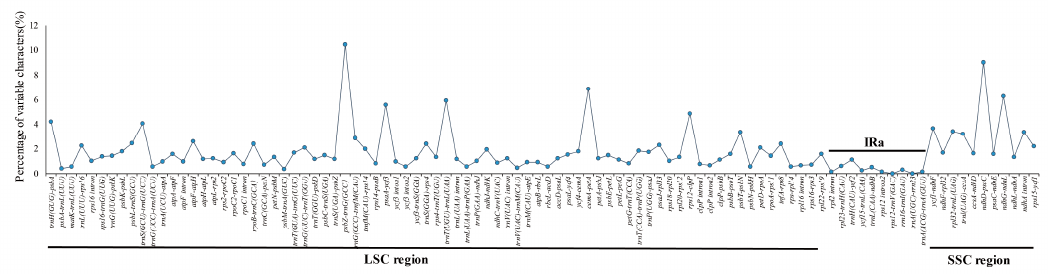
Figure 5. Percentage of variable characters in aligned noncoding regions of the six plastid genomes.